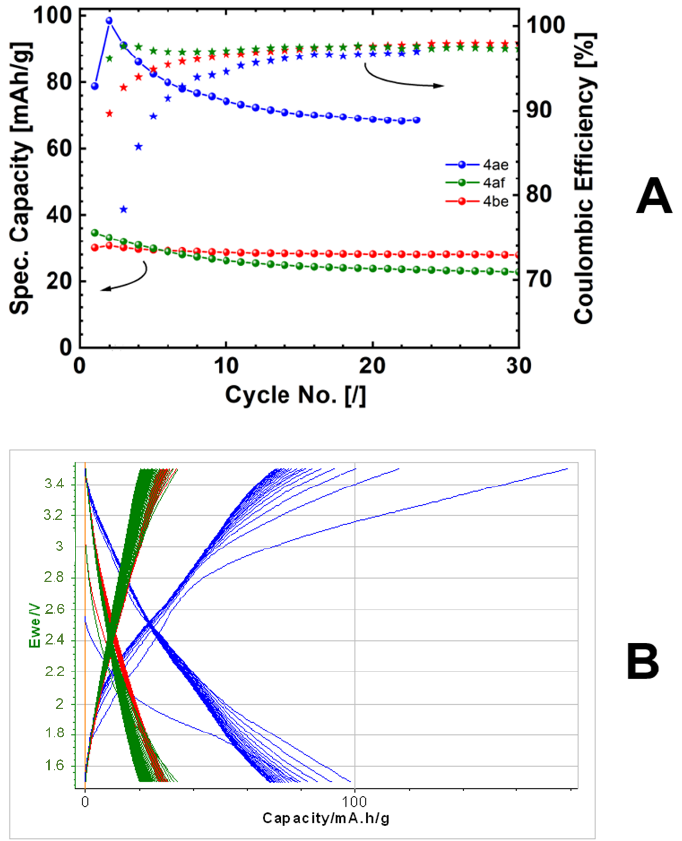
Figure 5. Capacity (full line) and Coulombic efficiency (stars) of compounds 4ae ( ▬ ), 4af ( ▬ ), and 4be ( ▬ ) vs. cycle number ( A ). Galvanostatic curves of com- pounds 4ae ( ▬ ), 4af ( ▬ ), and 4be ( ▬ ) ( B ).